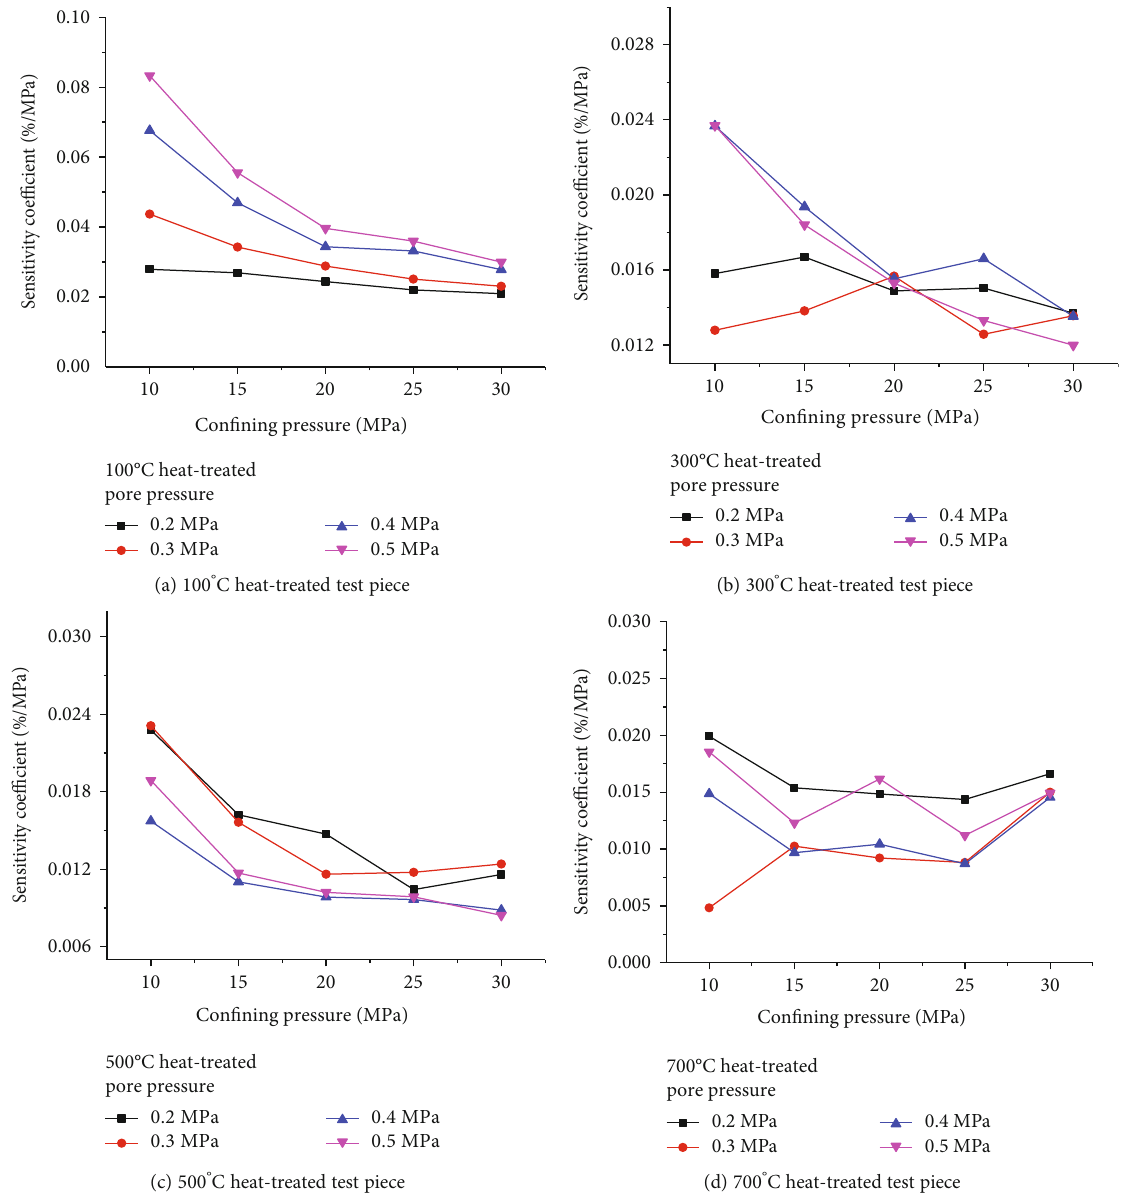
Figure 7: Con fi ning pressure permeability sensitivity coe ffi cient